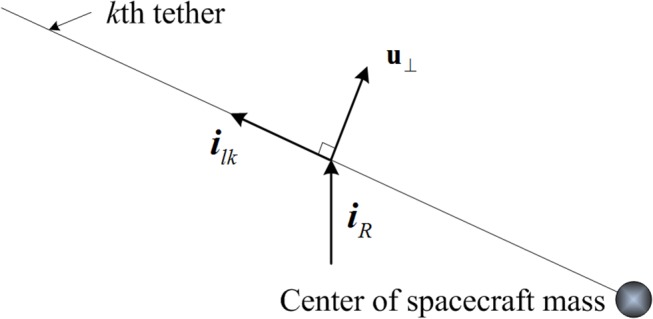
Thrust vector of kth tether.